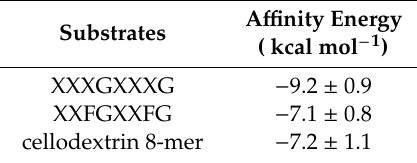
Table 3. A ffi nity energy of FcXTH2 protein model with three di ff erent octasaccharides as putative ligands. Determinations were performed by docking simulations using AutoDock Vina.